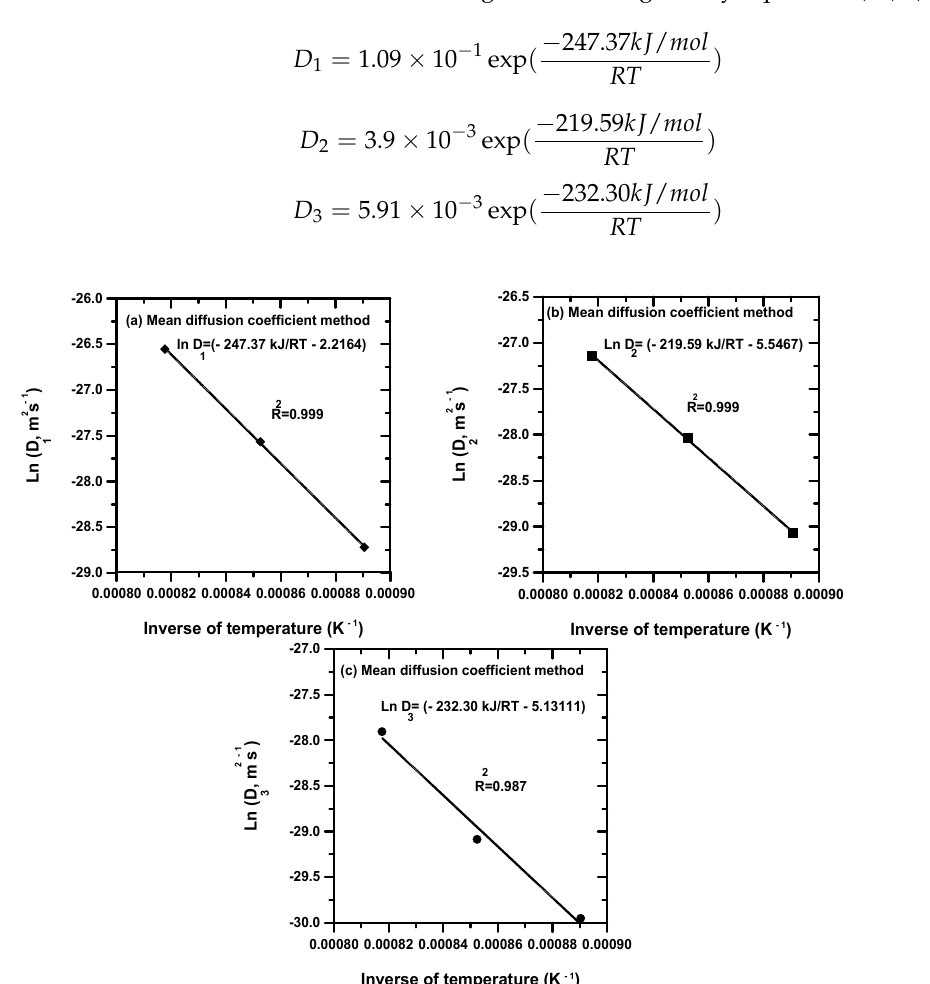
Figure 3. Arrhenius behaviors of calculated boron diffusivities in nickels borides with the help of MDC method.